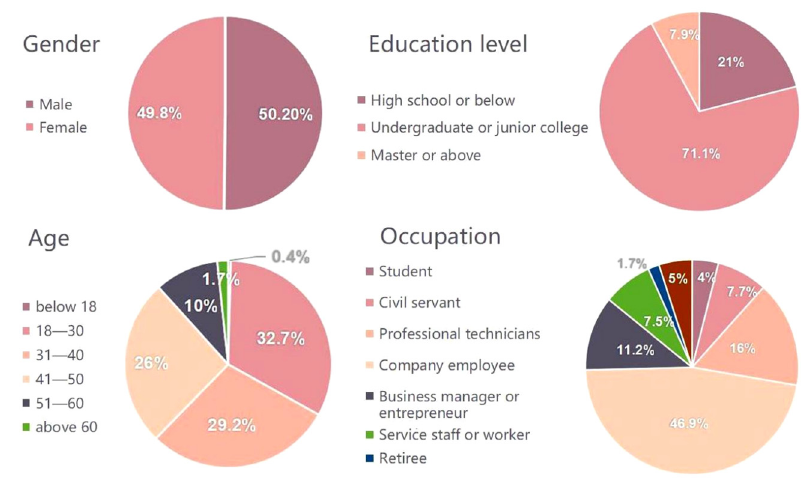
Table 6. Results of reliability tests of the evaluation scale for the six sample stations and all six combined.